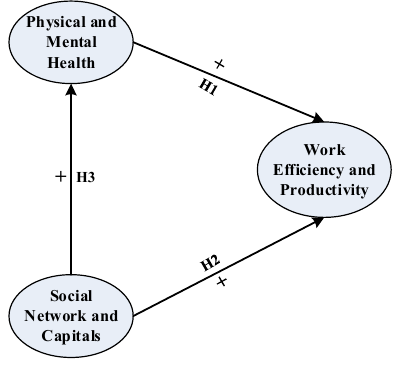
Figure 1. Proposed conceptual model.